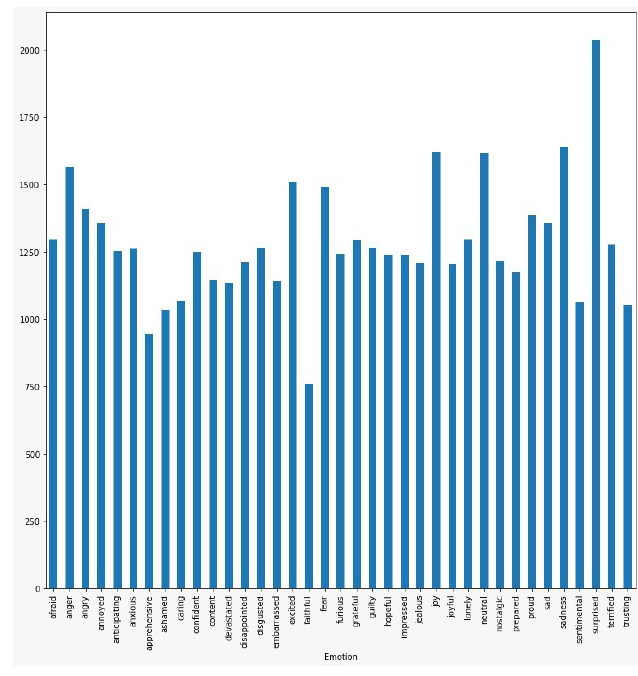
Fig 2 : Empathetic Dialogues